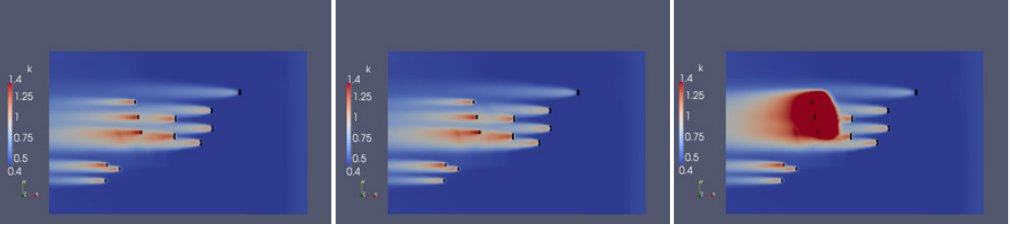
Figure 4. Magnitude of the wind speed (in ms − 1 ) at a height of 65m for case A (left), B (center) and C (right). Incoming wind from the WSW direction.